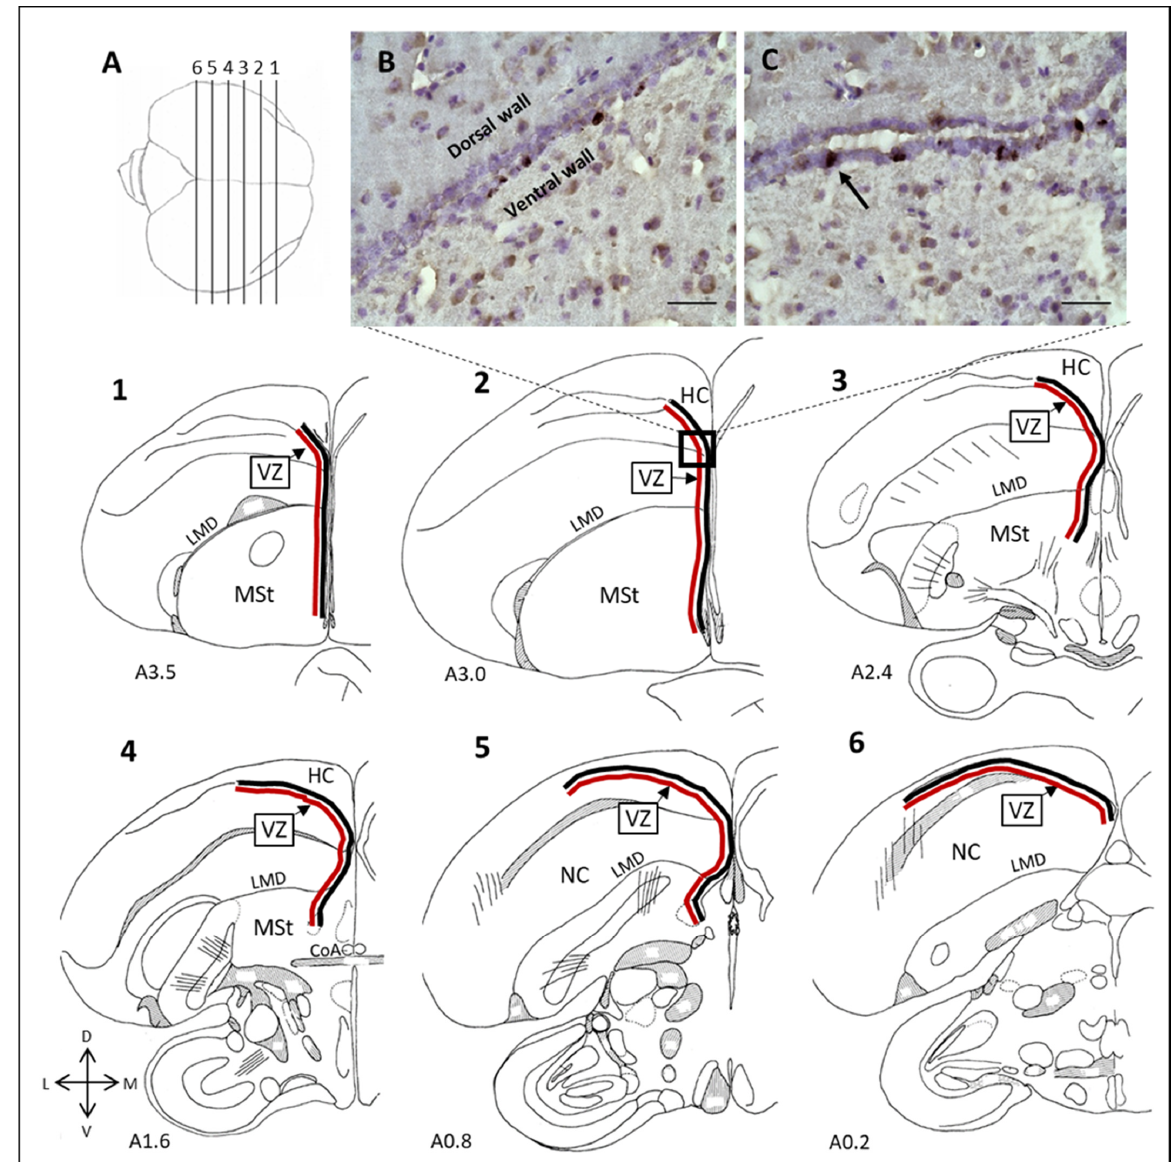
Figure 4. Mapping of cell proliferation in the ventricular zone (VZ). ( A ) Top view of a zebra finch brain (caudal is to the left, rostral is to the right). The numbered lines indicate the locations of the mapped sections, and frontal schematic illustrations of these sections are shown in 1–6 (taken from the atlas of the canary brain [42]). Red lines indicate the ventral walls of the VZ in each mapped section and the black lines indicate the dorsal walls. ( B , C ) Pictures showing two different small parts of the two walls of the VZ, to demonstrate new-born cells labelled with BrdU and stained dark brown (only one of the labelled cells is marked by an arrow). CoA, anterior commissure; HC, hippocampus; LMD, lamina medullaris dorsallis; MSt, medial striatum; NC, nidopallium caudale. Scale bar = 20 µm. (image adapted from [6]).